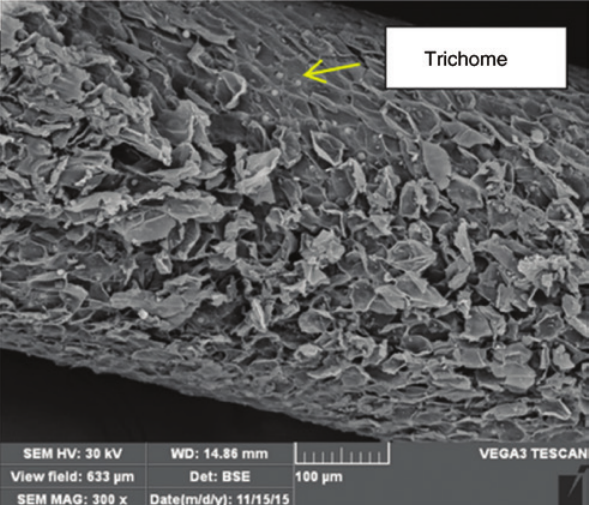
Figure 5: Micrographs of untreated DPFs.